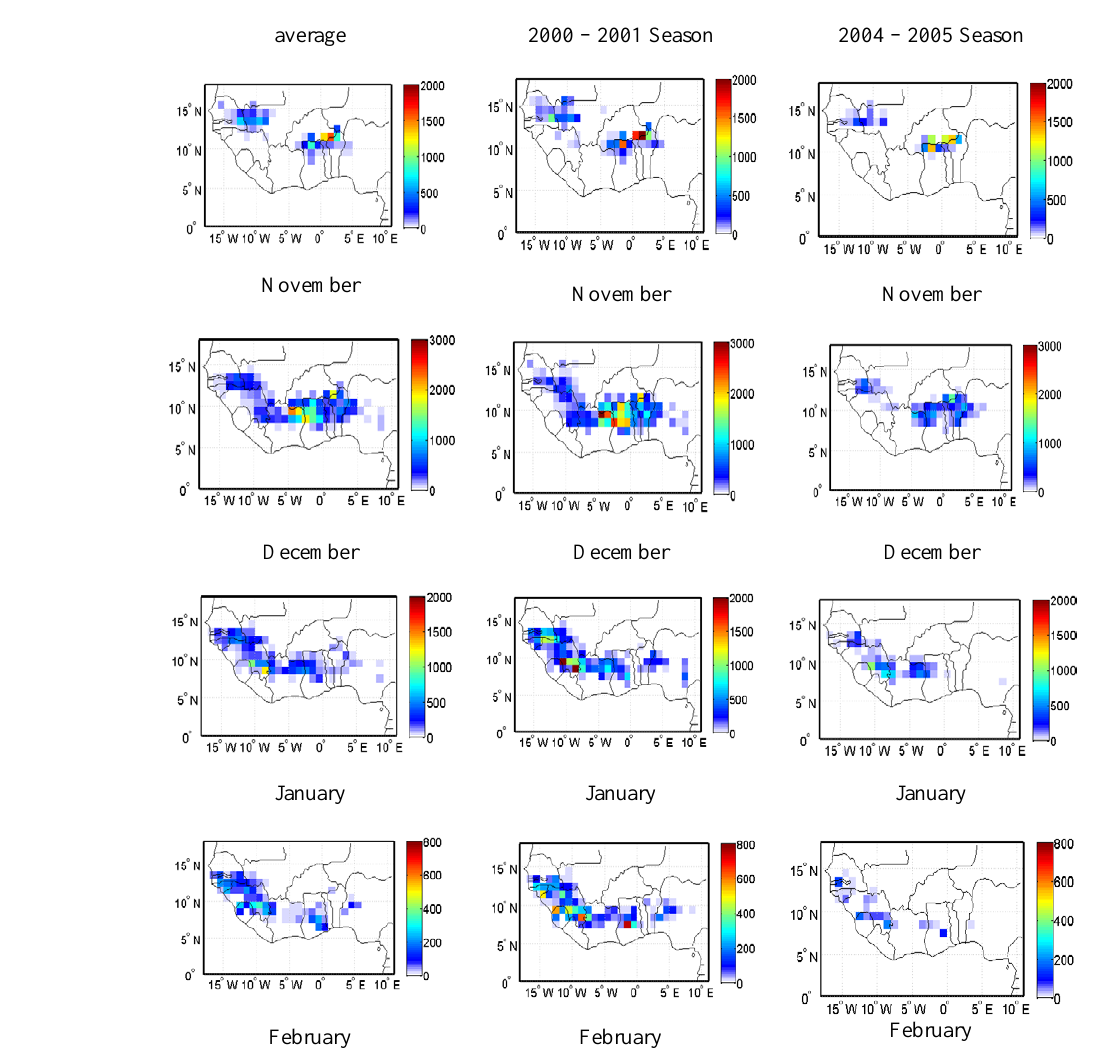
Figure 4. Spatial variability in burned areas (km 2 ) from November to February for the mean of the 7 years (left column) and for two contrasting years: high fire activity in 2000–2001 (middle column) and weak fire activity in 2004–2005 (right column).